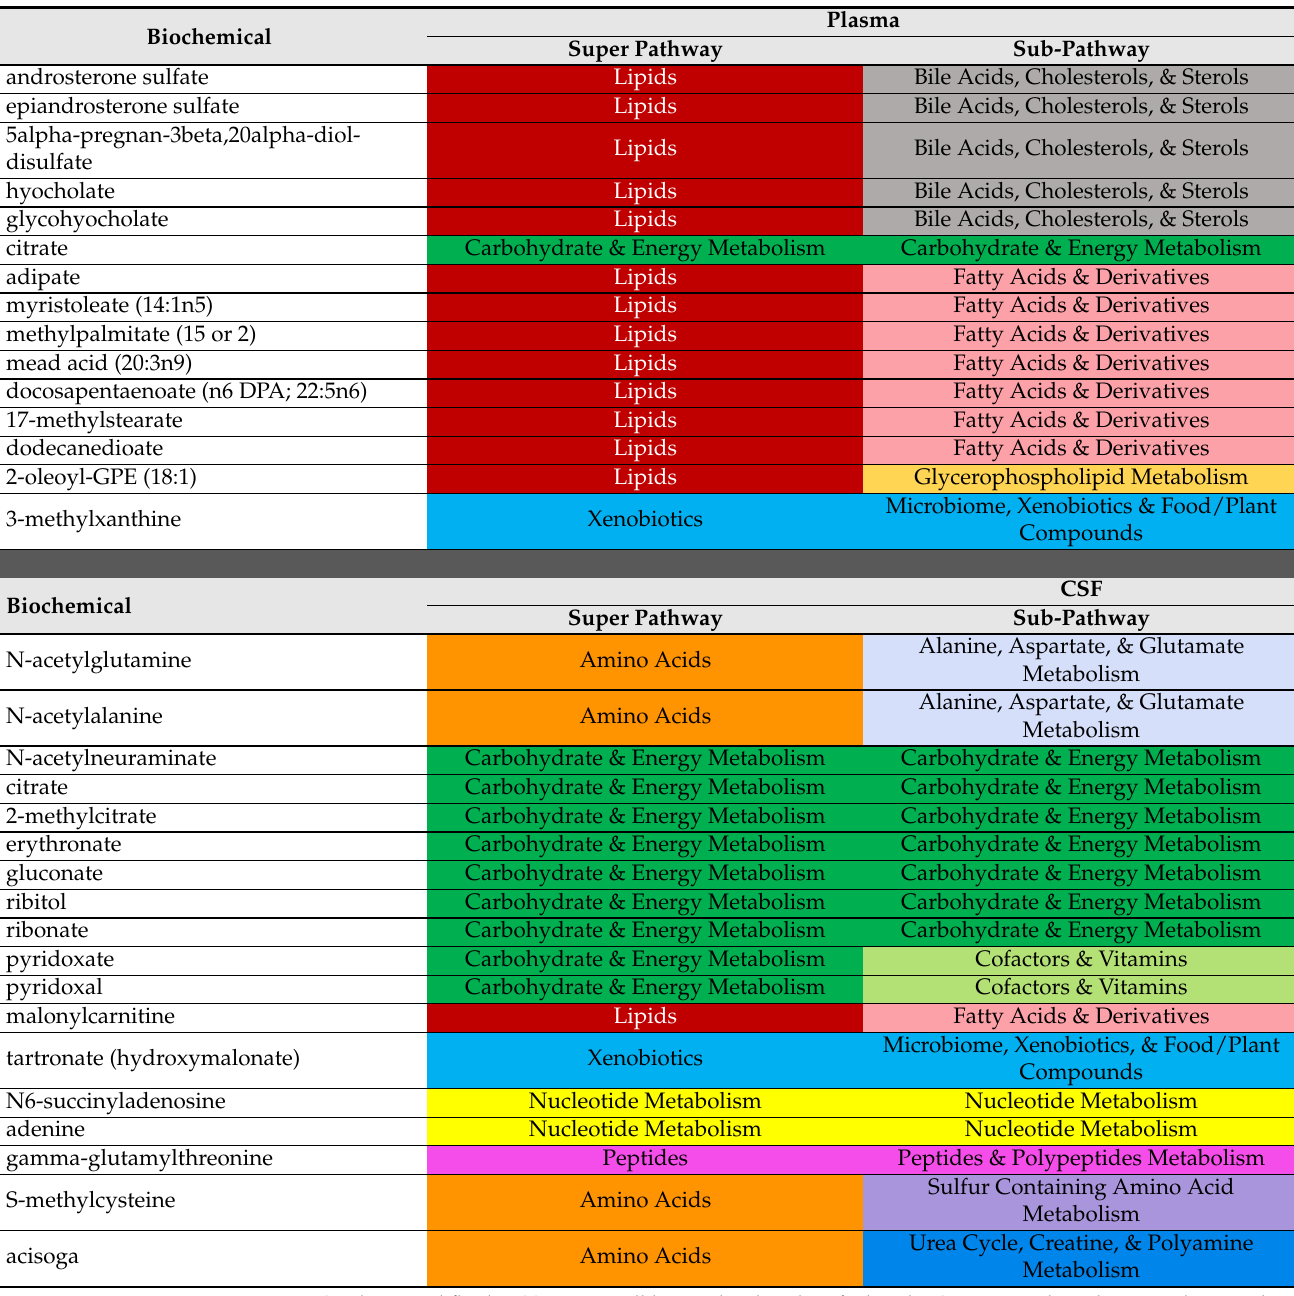
Table 2. Metabolites in the SLC13A5 Deficiency Disease Modules in Plasma and Cerebrospinal Fluid from Patients with SLC13A5 Deficiency as Determined by